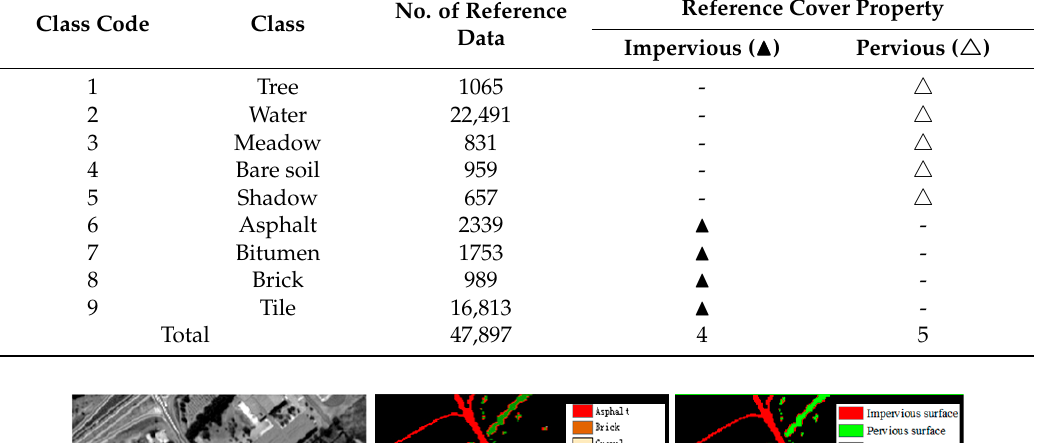
Table 3. The dataset display of land-cover classes and reference data in the city center scene of the Pavia, Italy.